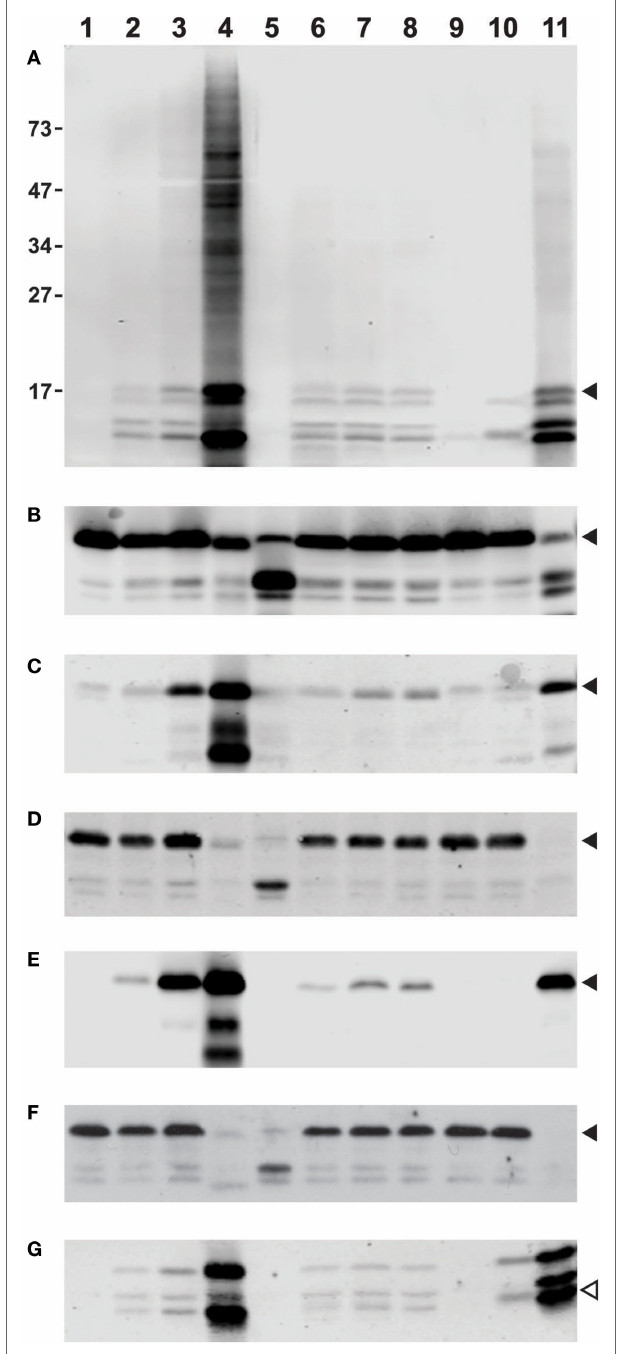
FiGUre 1 | Differences among commercial antibody-based reagents for the detection of deiminated core histones . Human neutrophils were purified from healthy donor blood according to published procedures and incubated for 2 h in HBSS (lane 1) or HBSS with 200 μ M calcium chloride (lane 2) and A27632 ionophore (lane 3), ionophore with 5 μ M chelerythrine (lane 4), or 20 μ M chelerythrine (lane 5). Cells were also incubated in the presence of 200 μ M calcium chloride and hydroxyapatite (lane 6) with added LPS (lane 7), or fMLP (lane 8), 20 nM PMA (lane 9), manganese chloride (lane 10), or lanthanum chloride (lane 11). The whole cell lysates were run